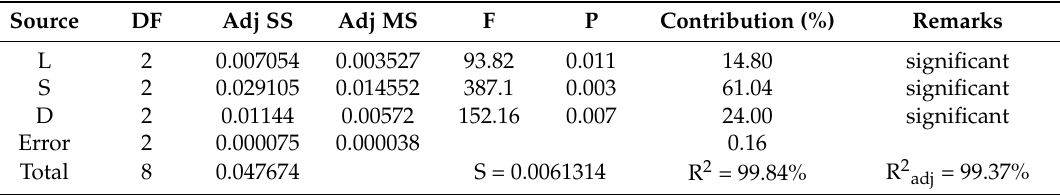
Table 11. ANOVA for grey relational grade.